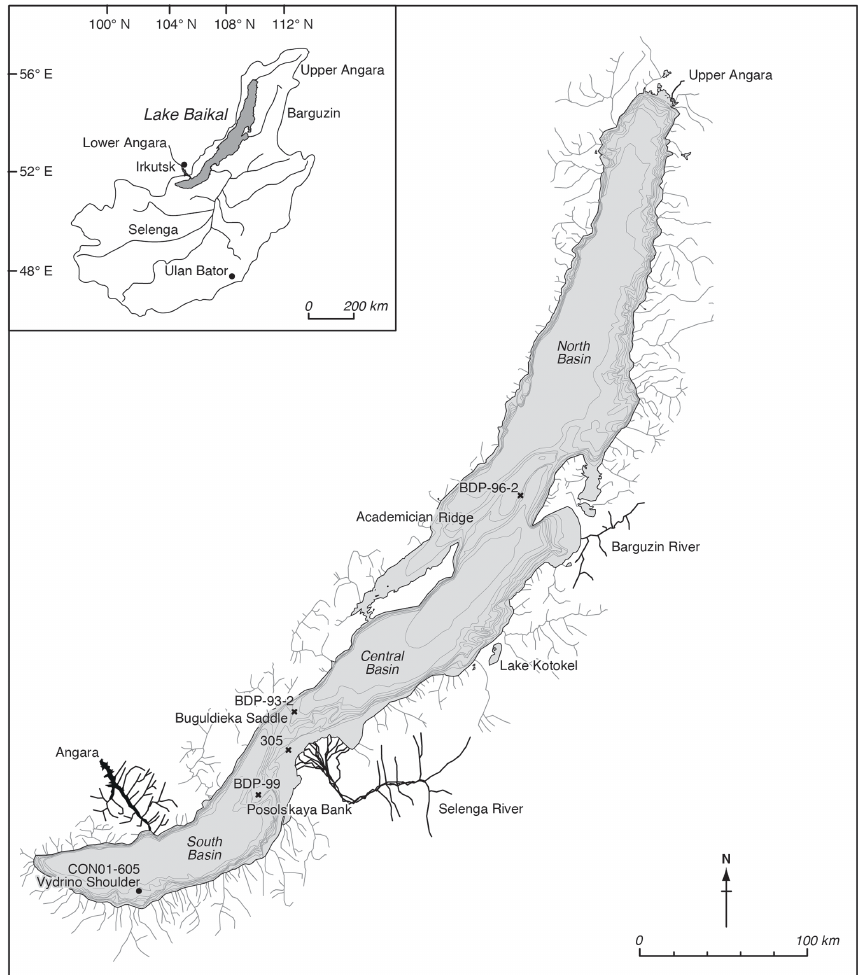
Figure 1. Map of Lake Baikal and its catchment, with locations of the different cores used or mentioned in this paper, including the coring location on the Vydrino Shoulder, where our study was undertaken. Also shown is Lake Kotokel, which has provided independent climate reconstructions used in this study (Tarasov et al.,